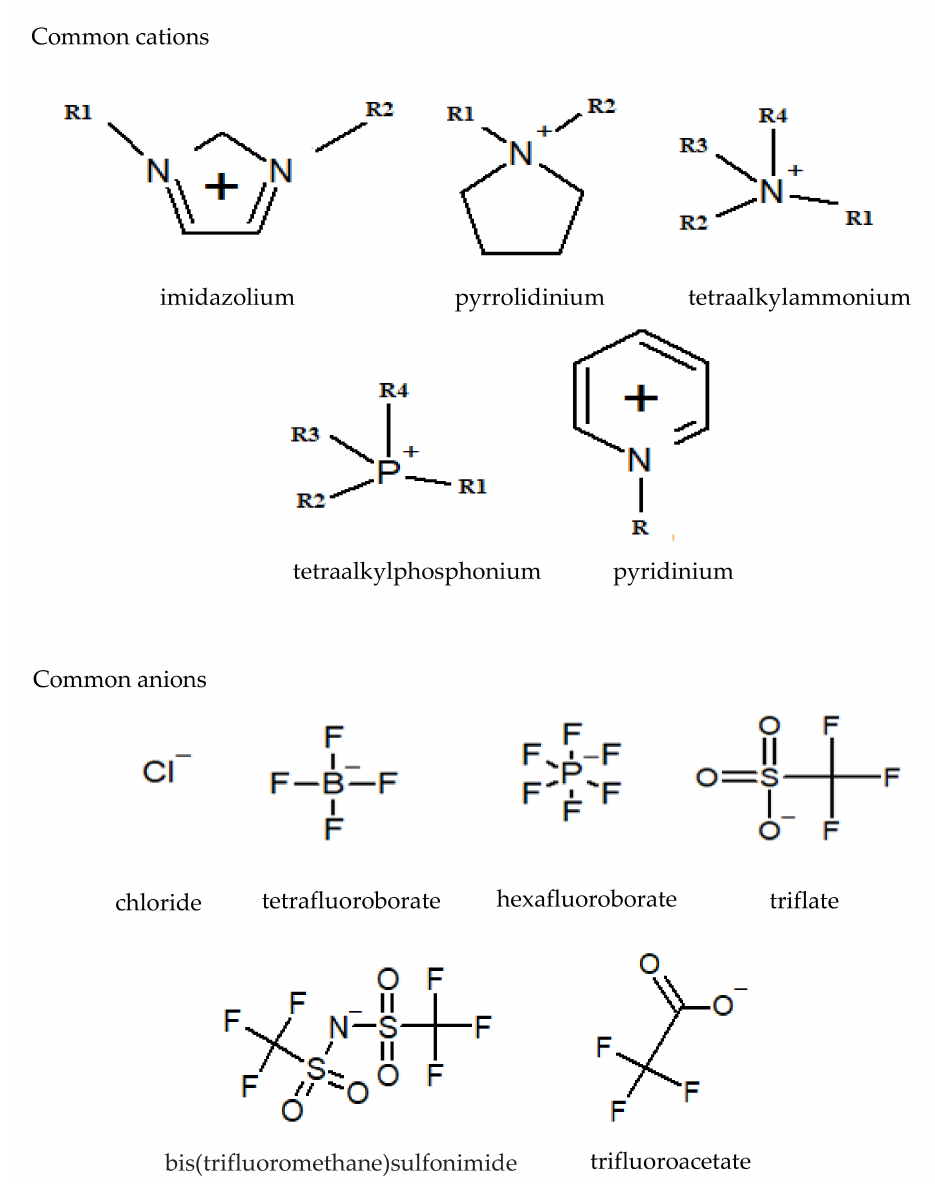
Figure 5. Chemical structure of the most common IL cations and